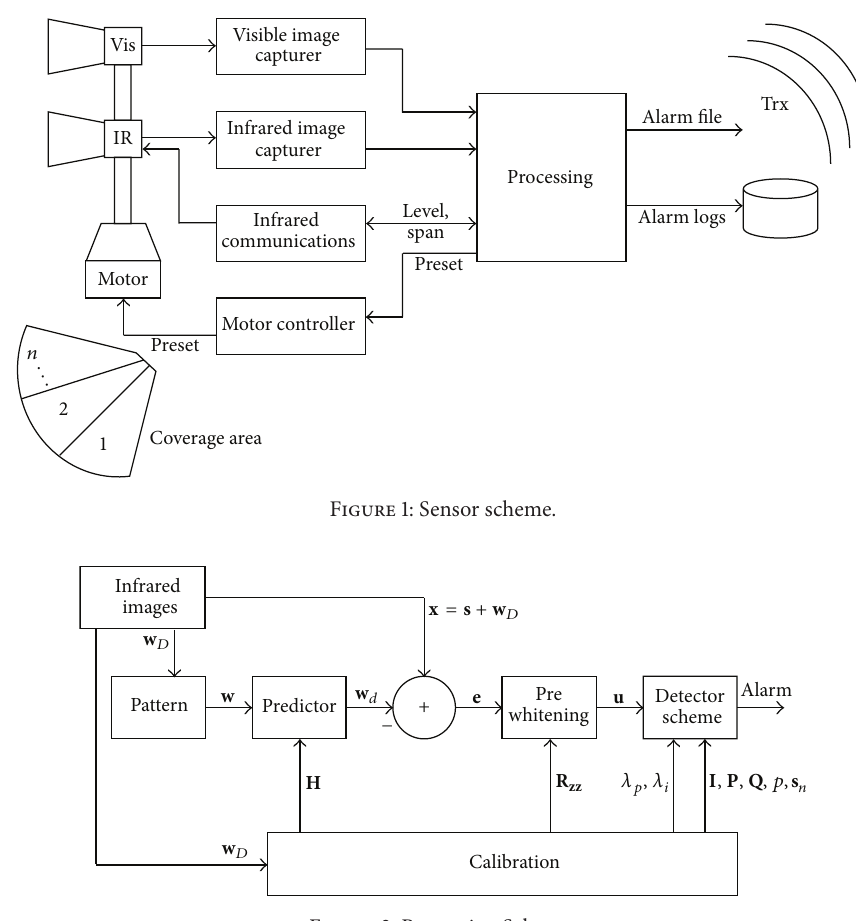
Figure 2: Processing